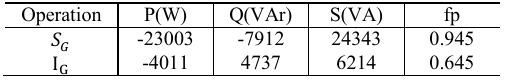
Table VII. Active, Reactive and Total Power and Power Factor in 𝑆 𝐺 e 𝐼 𝐺 for 𝑁 𝐿 .